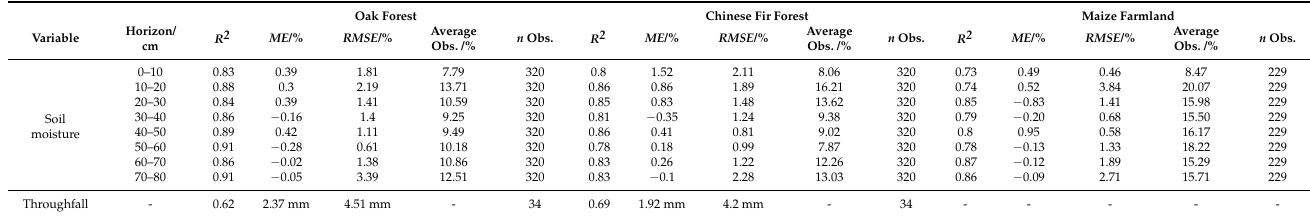
Table 3. Statistical performance of CoupModel.